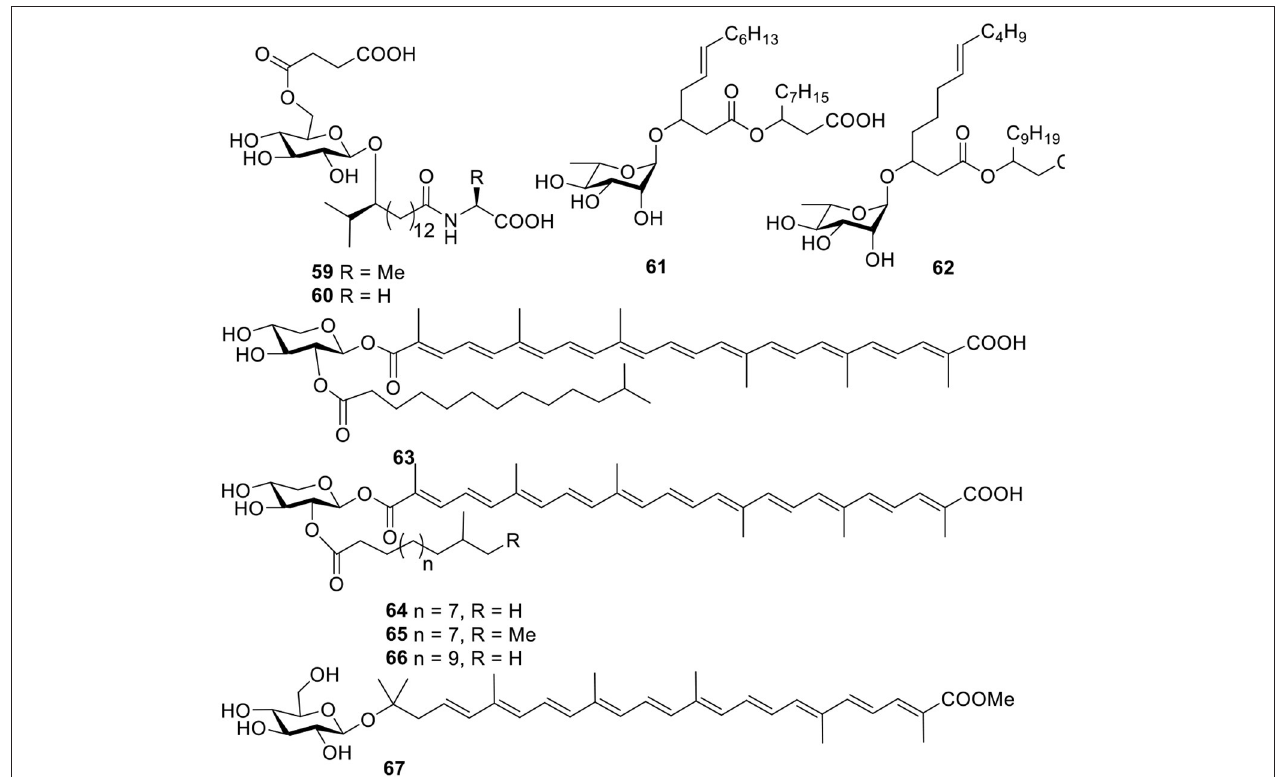
FIGURE 5 | Chemical structures of compounds 59–67 derived from marine-sourced